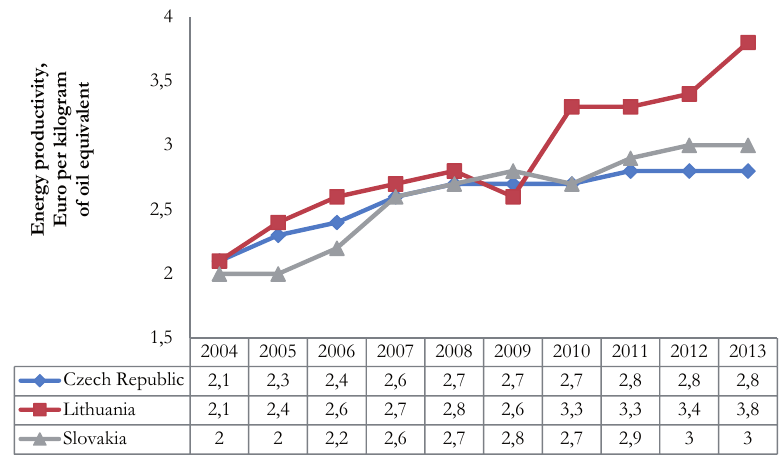
Fig. 1 – Energy productivity. Source: Eurostat. (2015a). Energy productivity. Retrieved February 22, 2016, from http://ec.europa.eu/eurostat/cache/metadata/EN/t2020_rd310_esmsip.htm From figure 1 it is distinguishable that all three countries – Czech Republic, Lithuania and Slo - vakia started from the same value (2.1; 2.1; 2) at the year 2004. Progressing up to year 2009, all values between the countries were very much similar, but after year 2009 to year 2013 it is visible that only Lithuania has managed to exceedingly increase itsenergy productivity, while Czech Republic stayed at 2.8 and Slovakia at 3 euro per kilogram of oil